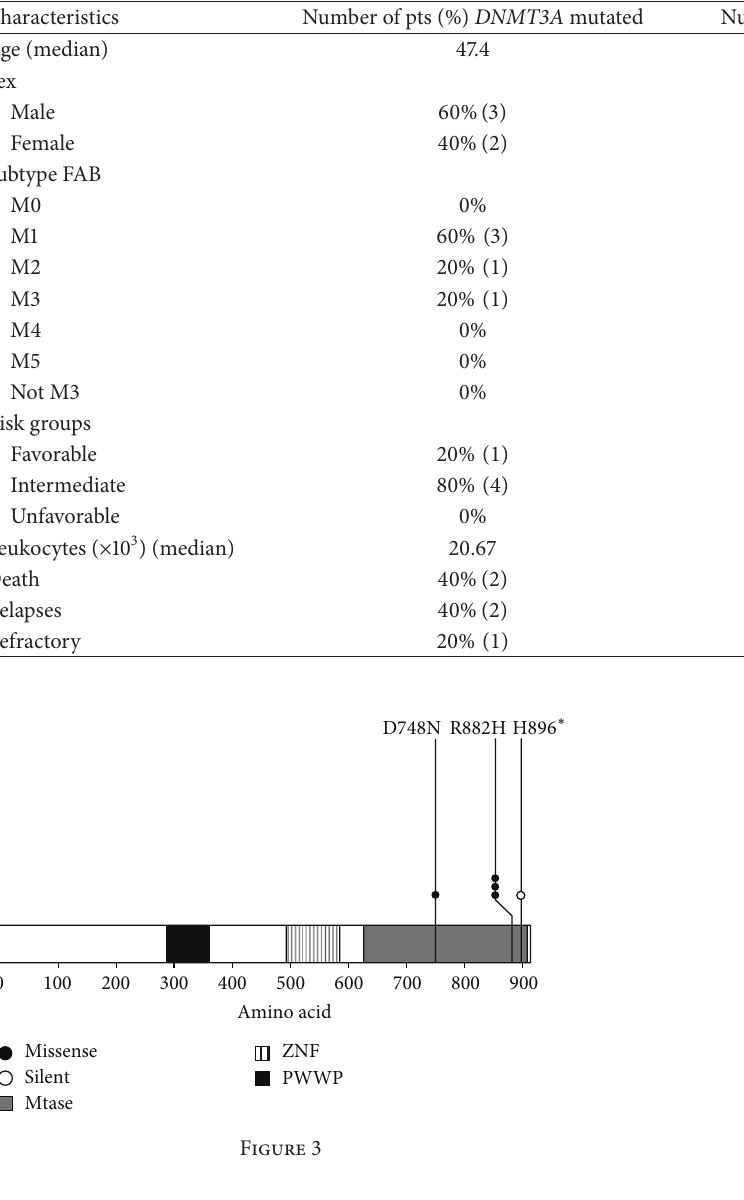
Table 5, line 20: In “50% (2), 30.9% (17) and 0.58” should read “40% (2), 29.2% (21) and 0.63”. We changed Figure 3 as shown